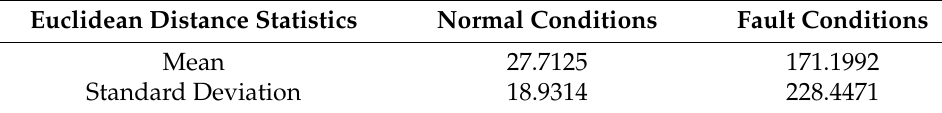
Table 5. 1000 Ω fault statistics.